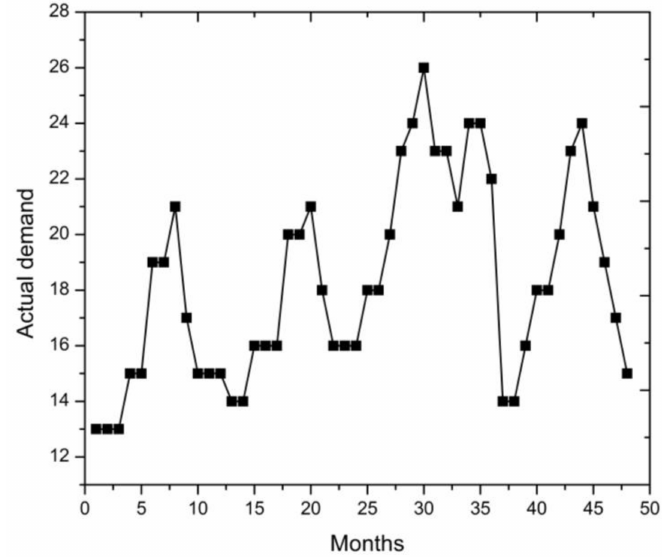
Figure 3. Four-year demand data for the 750 KV transformer